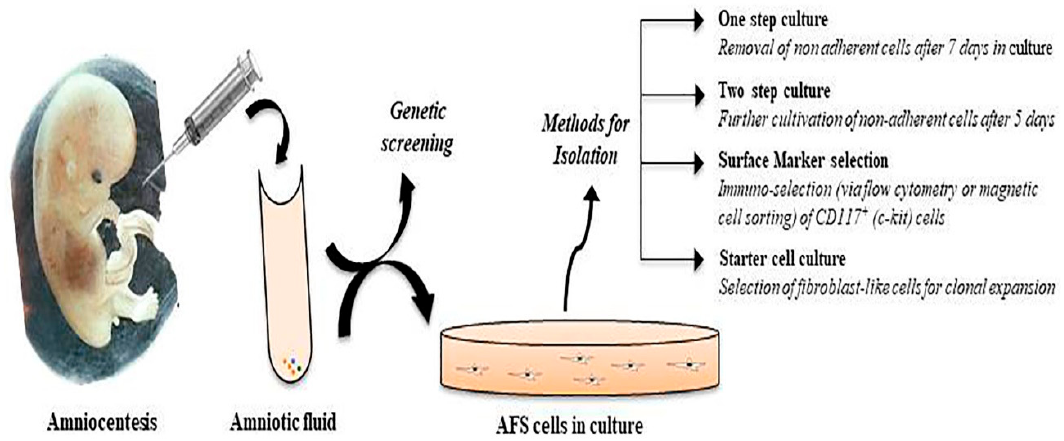
Figure 1. Isolation of human AFS cells and establishment of cell cultures.